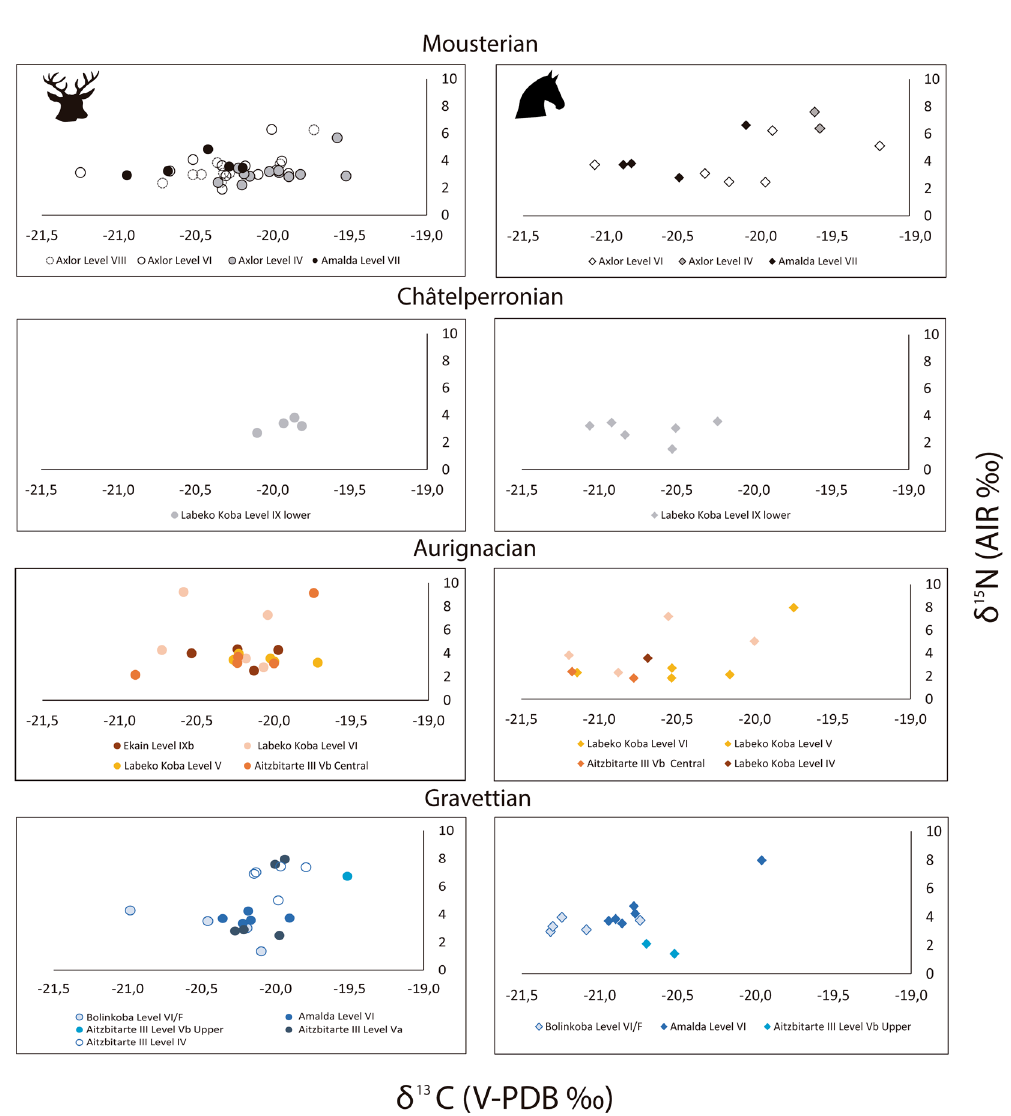
Figure 5. Bone collagen δ 13 C and δ 15 N values of red deer and horse specimens from the sites analysed in this study, for each cultural period and archaeological level. Red deer values are plotted on the graphs to the left (denoted as circles) and horse ones to the right (denoted as